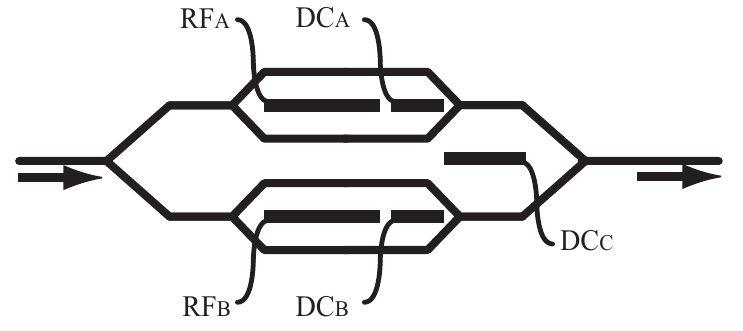
Figure 17. Optical SSB modulator.